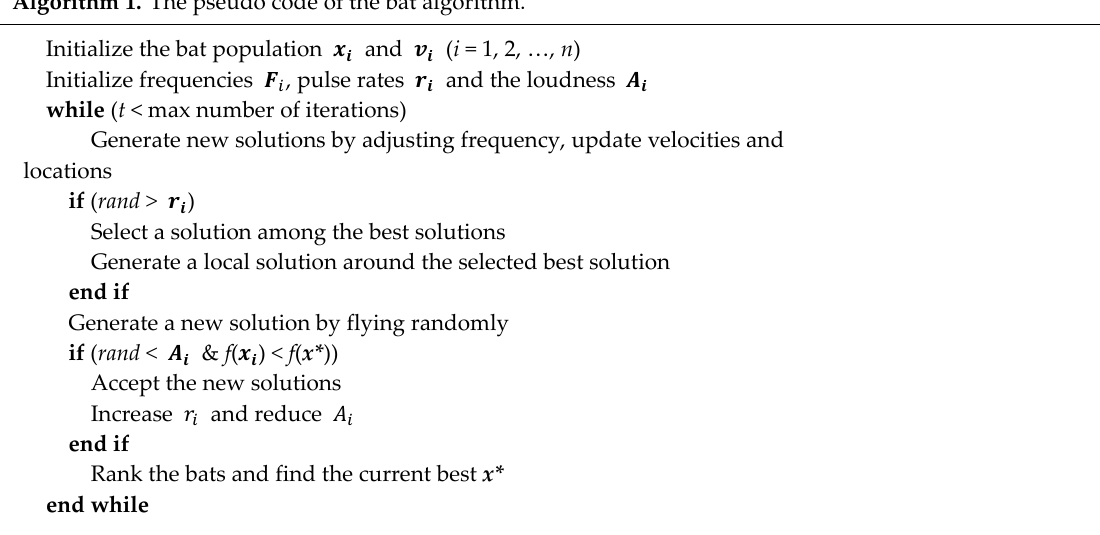
Algorithm 1. The pseudo code of the bat